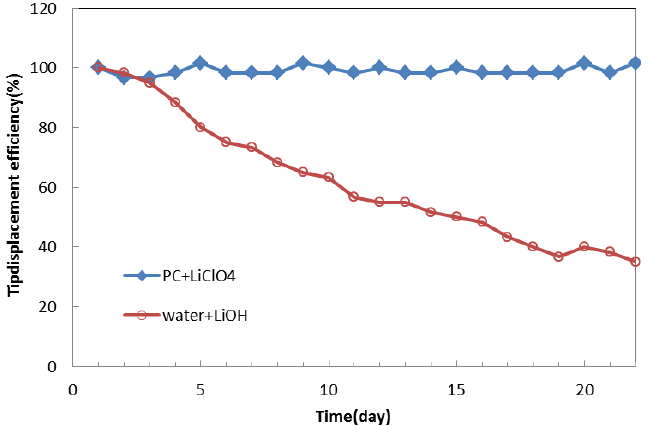
Figure 14. Variation of normalized tip displacement of IPMC with propylene carbonate and water